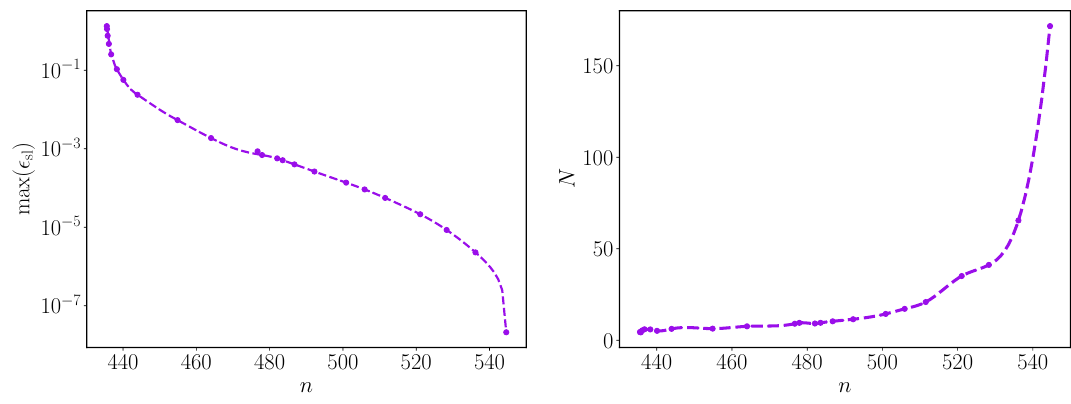
Figure 8 . For unstable Freund-Rubin solutions with n I < n < n c we plot the maximum value the slow-roll parameter (cid:15) takes during the evolution (left) and the number of e-folds of expansion in sl the four-dimensional effective theory elapsed during the transition to the stable warped end-point (right).